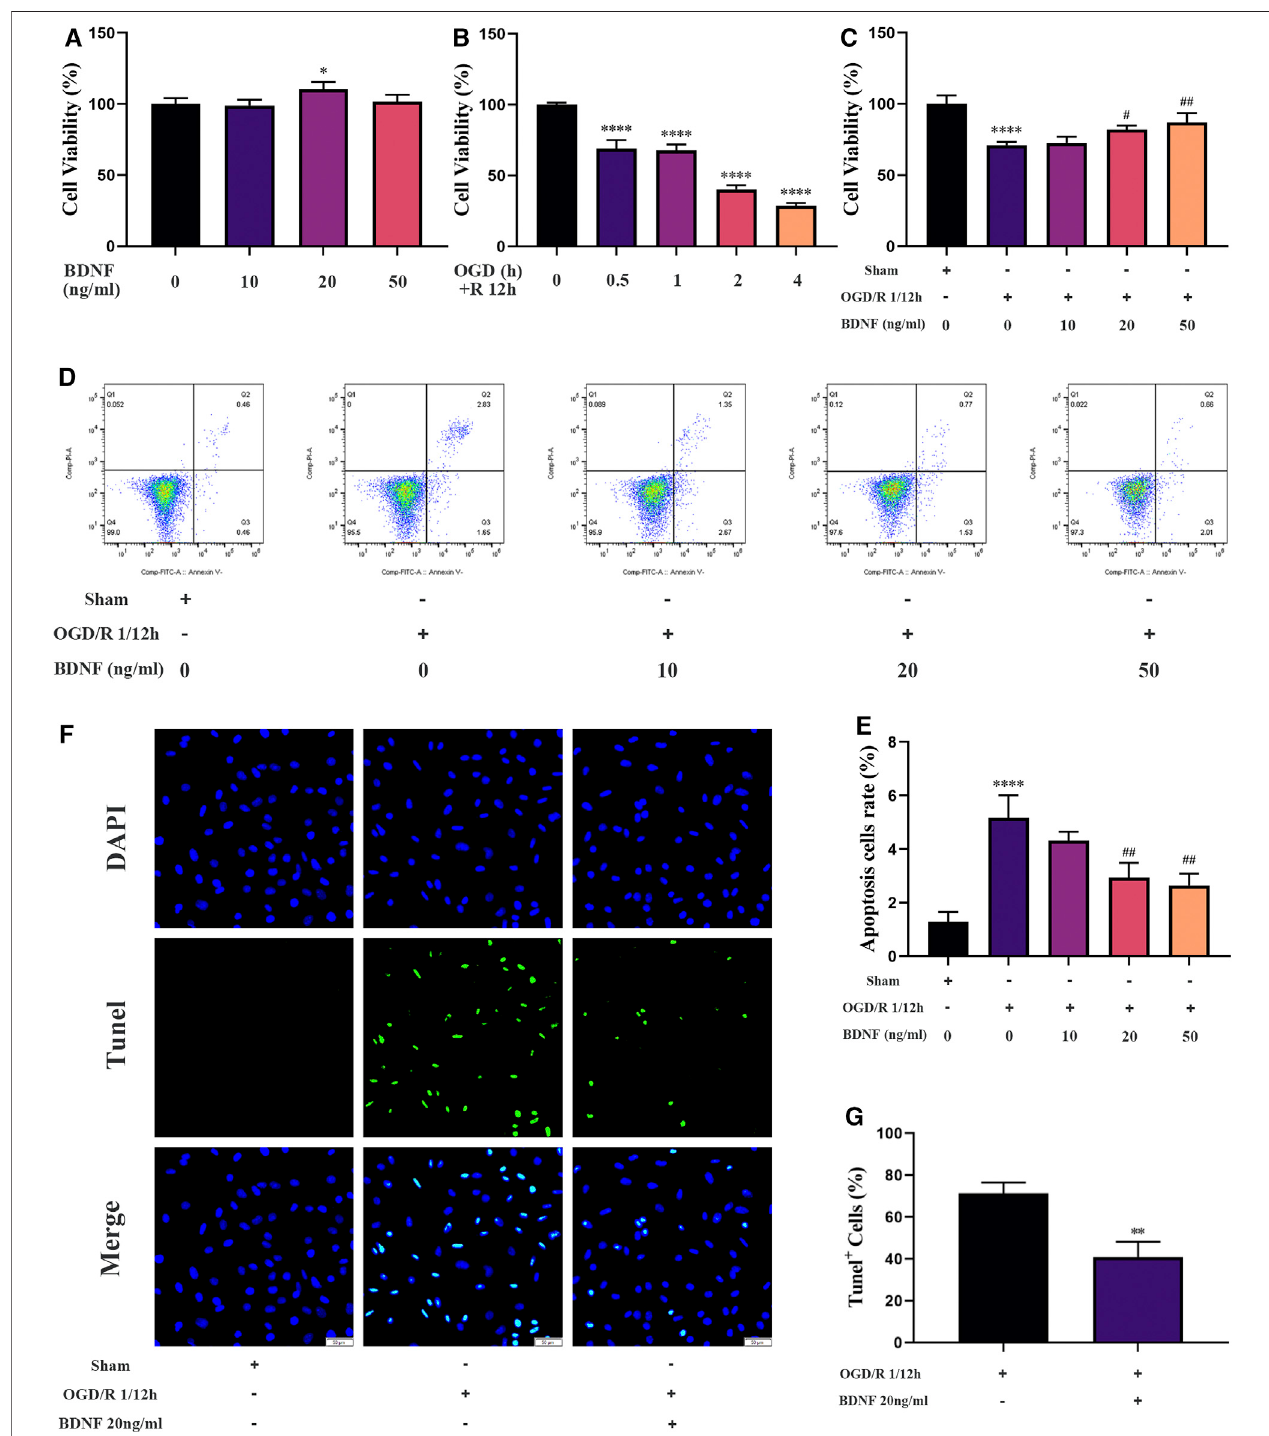
FIGURE7| BDNFpromotestheproliferationofSH-SY5YcellsandinhibitscellapoptosisunderOGD/Rconditions. (A – C) TheeffectofBDNFontheproliferationof SH-SY5Y cells was detected by CCK-8 assay under OGD/R conditions ( n = 4). (D – G) The effect of BDNF on apoptosis of SH-SY5Y cells was detected by TUNEL staining ( n = 3, bar = 50 μ m) and fl ow cytometry ( n = 3). (* p < 0.05, ** p < 0.01, **** p < 0.0001 vs. sham; # p < 0.05, ## p < 0.01 vs. OGD/R 1/12 h).